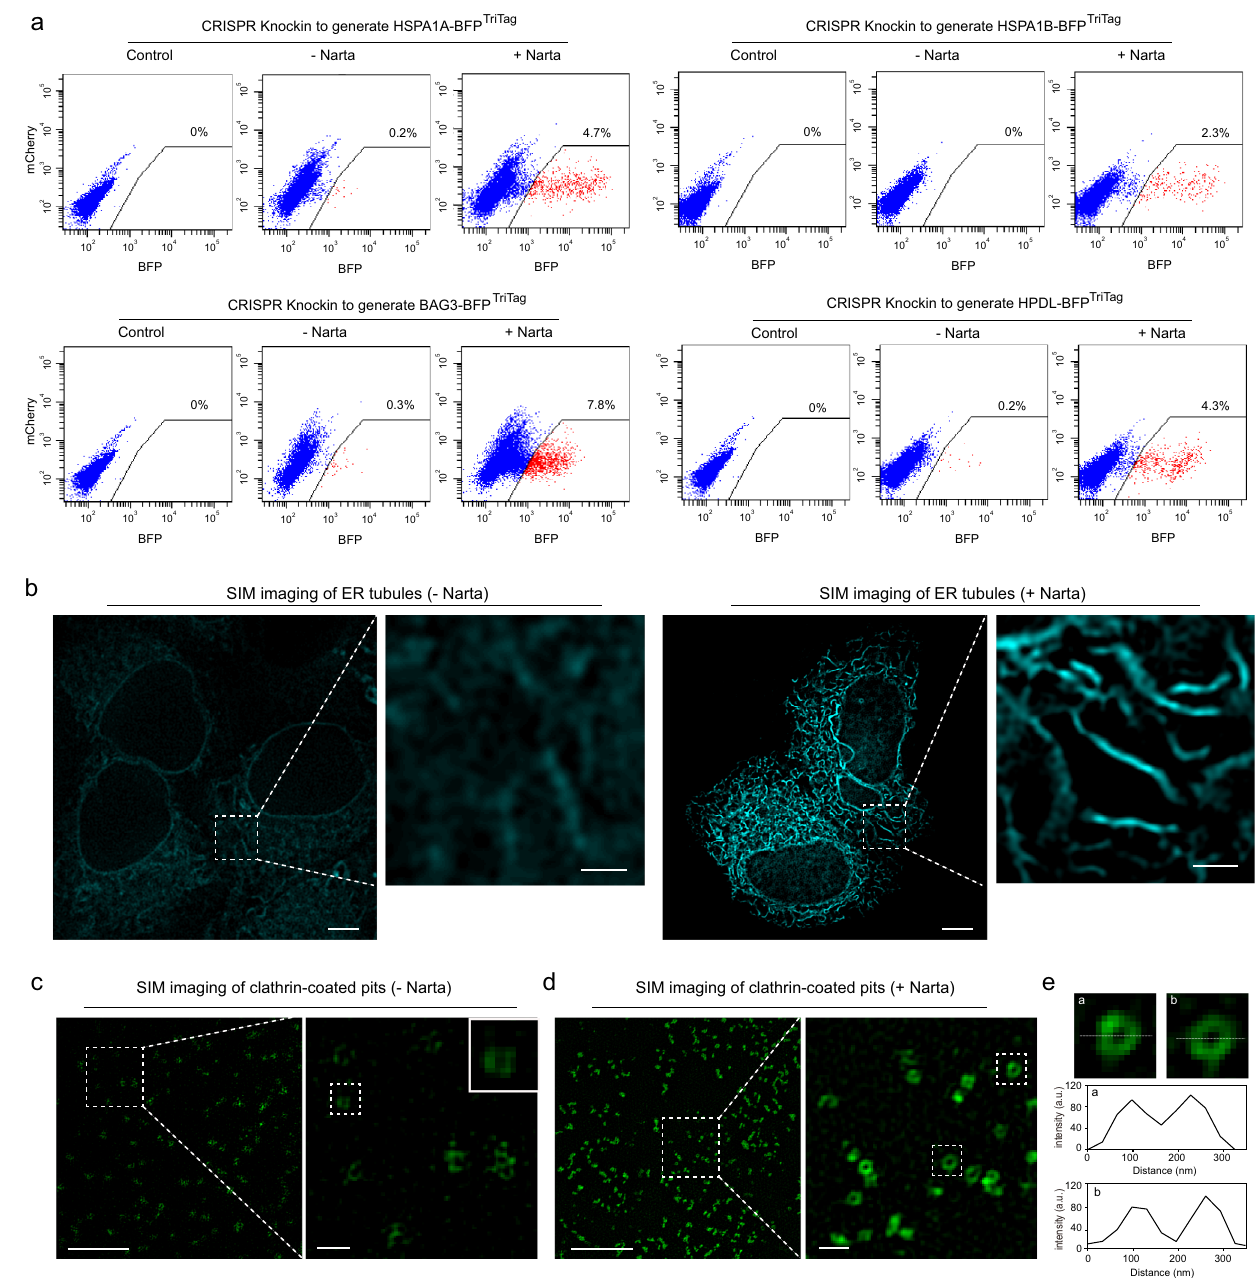
c , d SIM imaging of clathrin-coated pits labeled by CLTA-GFP TriTag with or without Narta activation. Scale bar of the large fi eld imagesis5 μ m. The regionin the white boxisfurtherdisplayedinazoomed-inviewwith500nmscalebar.Magni fi edview of a representative donut-shaped clathrin-coated vesicle from c is shown. e Magni fi edviewoftworepresentativedonut-shapedclathrin-coatedvesiclesfrom d , left. Line scan of the relative fl uorescenceofCLTA-GFP TriTag is generatedtoshow the size of clathrin-coated